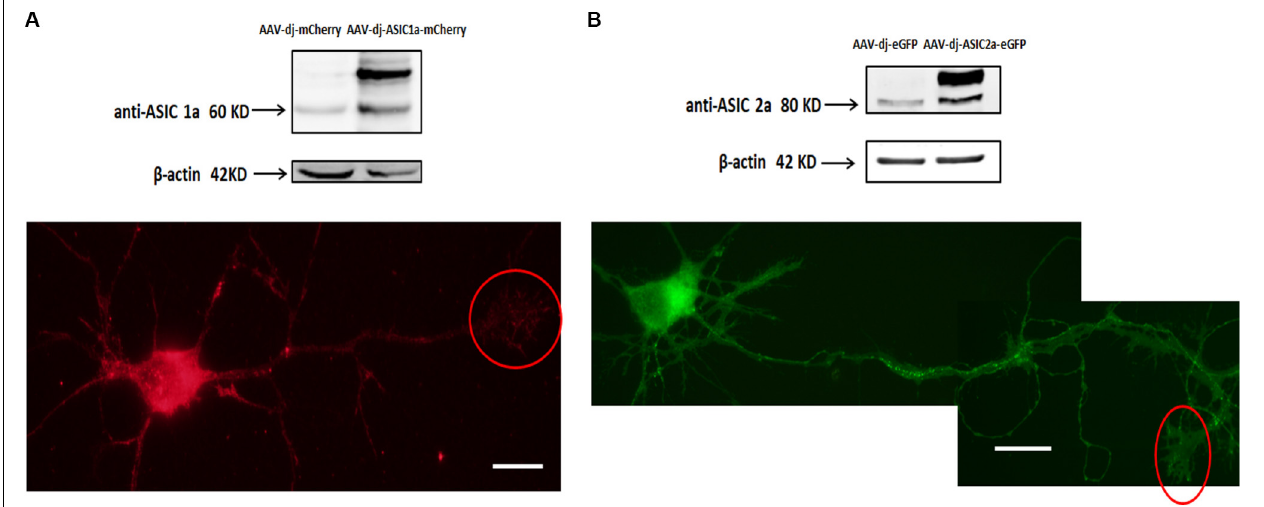
FIGURE 2 | Transduced ASIC1a and ASIC2a is expressed at the axonal growth cones. (A) Primary hippocampal cultures were transduced with AAV-dj-mCherry and AAV-dj-ASIC1a-mCherry. The above panel shows that the protein expression (AAV-dj-ASIC1a-mCherry) of ASIC1a (60 kD) and fusion mCherry (28.8 kD) was higher than that of the proteins in the control groups (AAV-dj-mCherry). The below panel shows that ASIC1a overexpression signal was also distributed at the axonal growth cones (red circle). (B) Primary hippocampal cultures were transduced with AAV-dj-eGFP and AAV-dj-ASIC2a-eGFP. The above panel shows that the protein expression (AAV-dj-ASIC2a- eGFP) of ASIC2a (80 kD) and fusion eGFP (27 kD) was higher than that of the proteins in the control groups (AAV-dj-eGFP). The below panel shows that exogenous overexpression of ASIC2a was also localized at the axonal growth cones (red circle). Scale bars, 20 µ